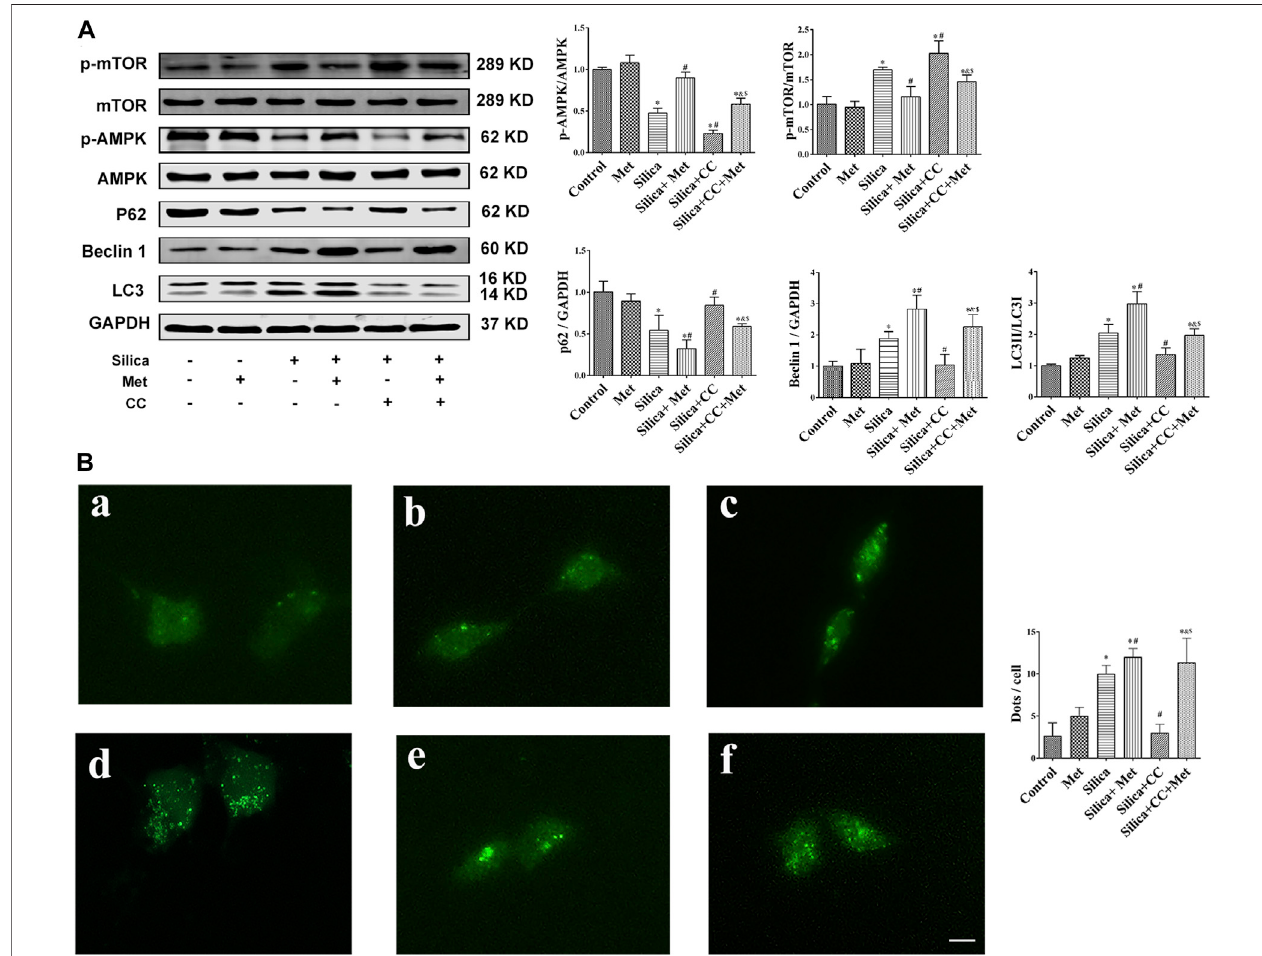
FIGURE 8 | Metformin activates autophagy via the AMPK-mTOR signaling pathway. (A) The protein levels of AMPK, p-AMPK, mTOR and p-mTOR, p62, Beclin1 and LC3 in HBEC were detected by western blot. (B) Fluorescence images of Ad-GFP-LC3 in HBEC cells after co-culture 72 h. GFP fl uorescence indicated by green puncta. a Control group; b Met treatment group; c Silica group; d Silica+0.5 mM Met group; e Silica+0.1 μ M CC group; f Silica+0.5 mM Met +0.1 μ M CC group. Scale bars,30 μ m.Allthedataarepresentedasmean ± SD( n (cid:2) 3foreachexperimental group).* p < 0.05,comparedtothenegativecontrolgroup; # p < 0.05,compared to silica group; & p < 0.05, compared to Silica + Met group; $ p < 0.05, compared to Silica + CC group. AMPK, adenosine5 ′ -monophosphate (AMP)-activated protein kinase; mTOR, mammalian Target of Rapamyc; LC3, microtubules associated protein 1 light chain 3; Met, metformin; CC, Compound